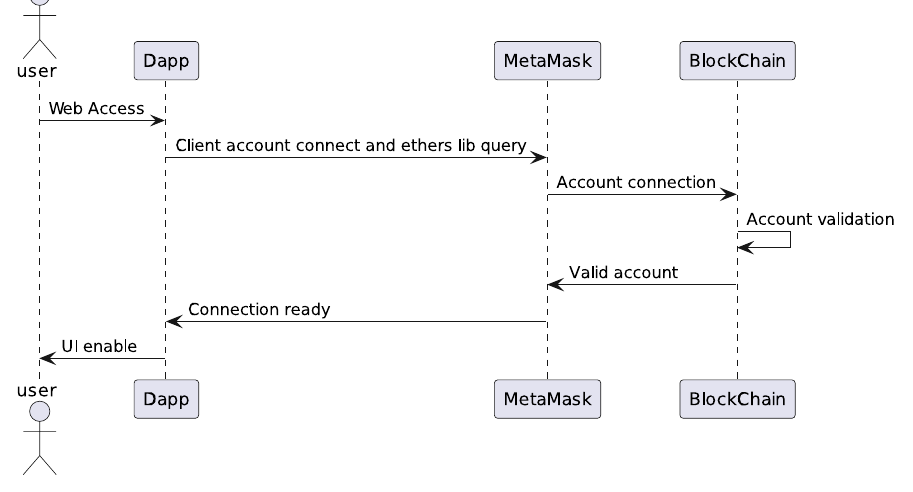
Figure 3. DAPP login process.